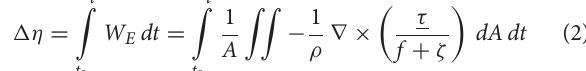
FIGURE 6 | (A) Temporal evolution of short-lived coastal anticyclones detected in 2015 with AMEDA algorithm from DYNED-Atlas eddy database and from CROCO-MED60v40-2015 simulation. The dynamical characteristics of the eddy, its velocity V max ( m / s ) and radius R max ( km ) are shown in (A,B) , respectively while their trajectories are illustrated in (C) . The evolution and the trajectory of the anticyclones AE1, AE2, and AE3 tracked in the regional model are plotted with blue lines while the observed anticyclone (DYNED-Atlas data-base) is plotted with a black